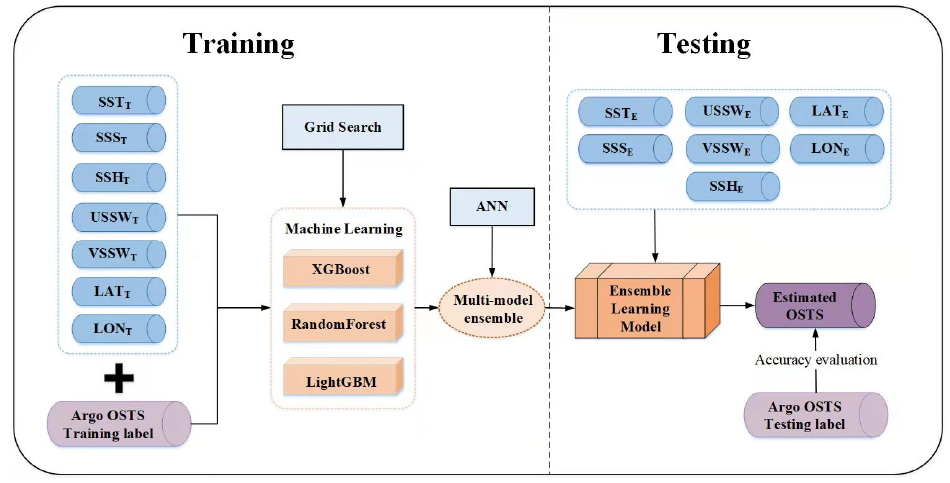
Figure 2. Flowchart for the ensemble machine learning (Ens-ML) model for ocean subsurface thermal structure estimation in the SCS.